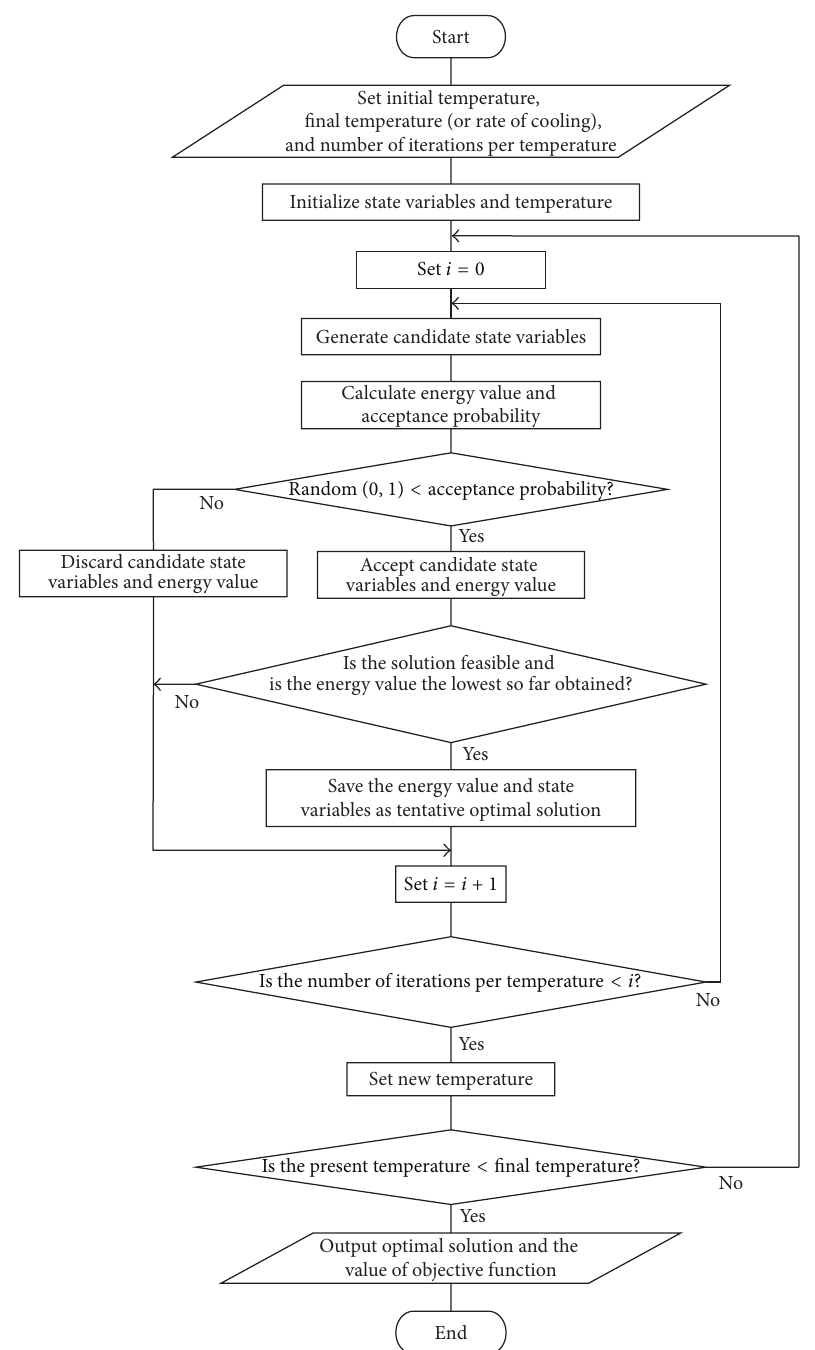
Figure 1: Flowchart of SA